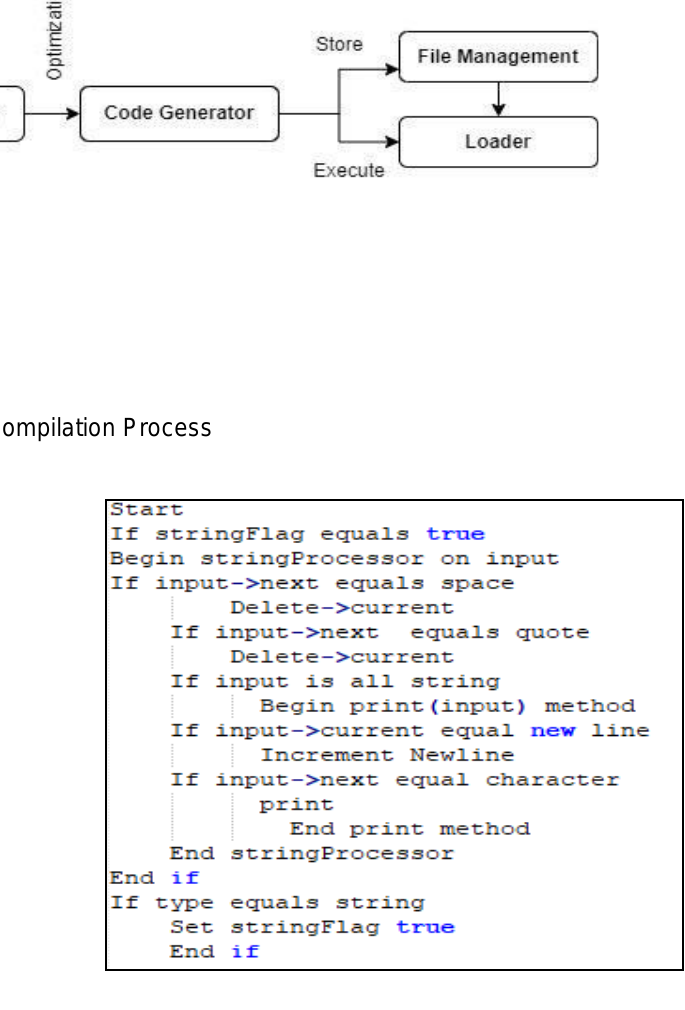
Figure 2. Algorithm for searching